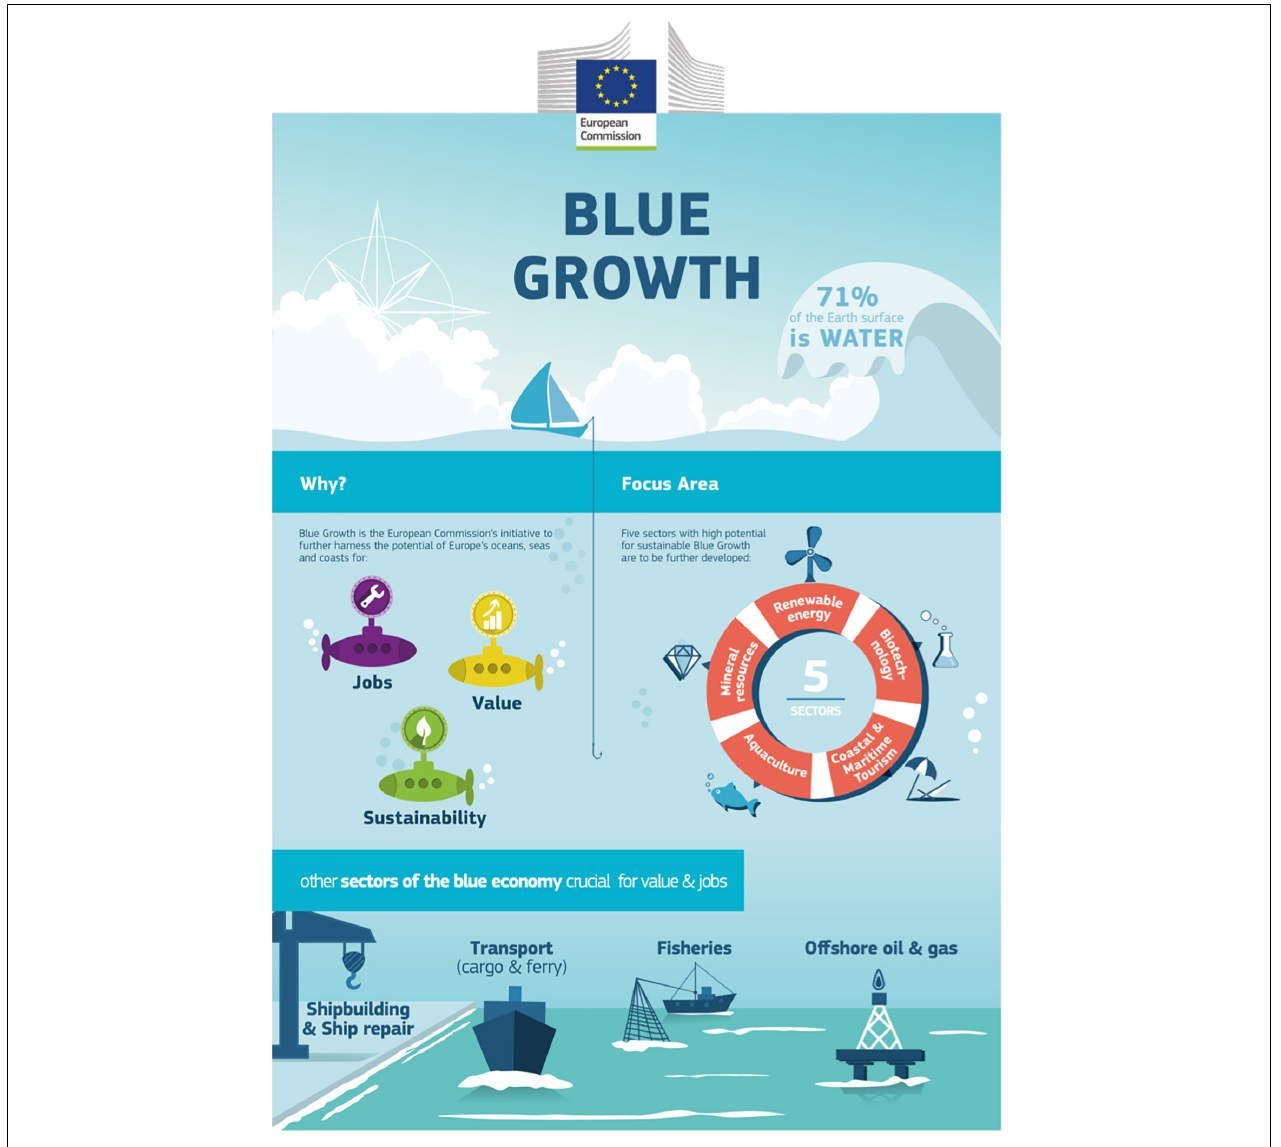
FIGURE 1 | Schematic depiction of the EU Blue Growth Strategy’s focus area, reasoning, and other crucial sectors for the Blue Economy Adapted from European Commission (2012).